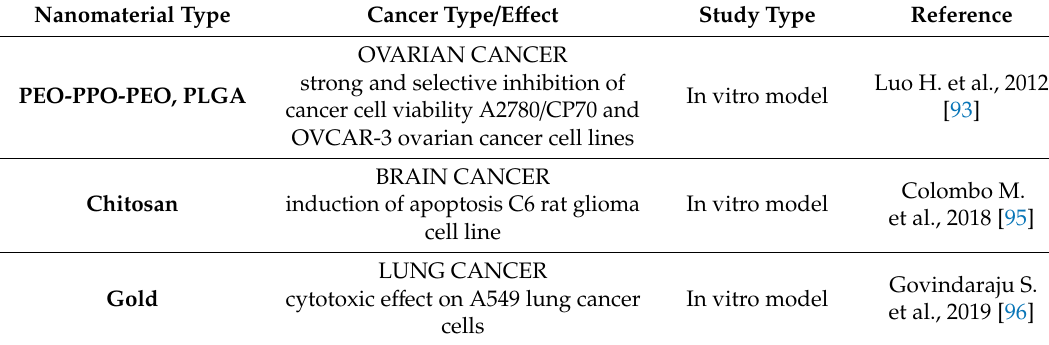
Table 8. Anticancer e ff ect of kaempferol nanoparticles in in vitro studies.